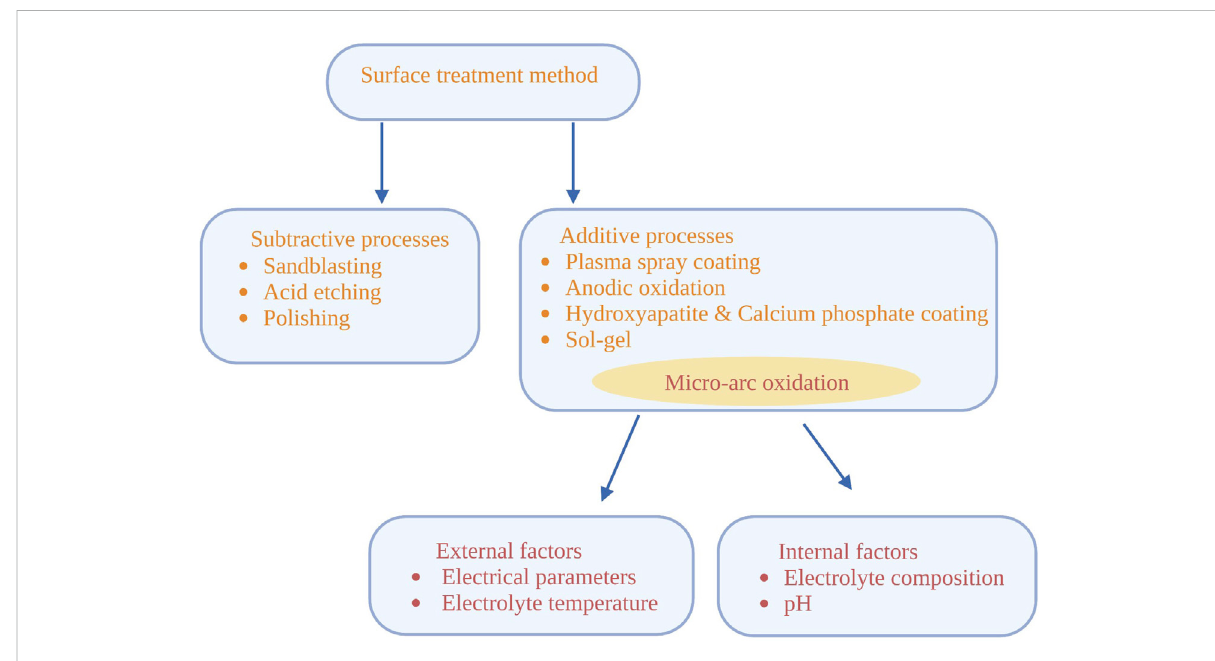
FIGURE 2 Surface treatment methods of titanium substrate and factors affecting micro-arc